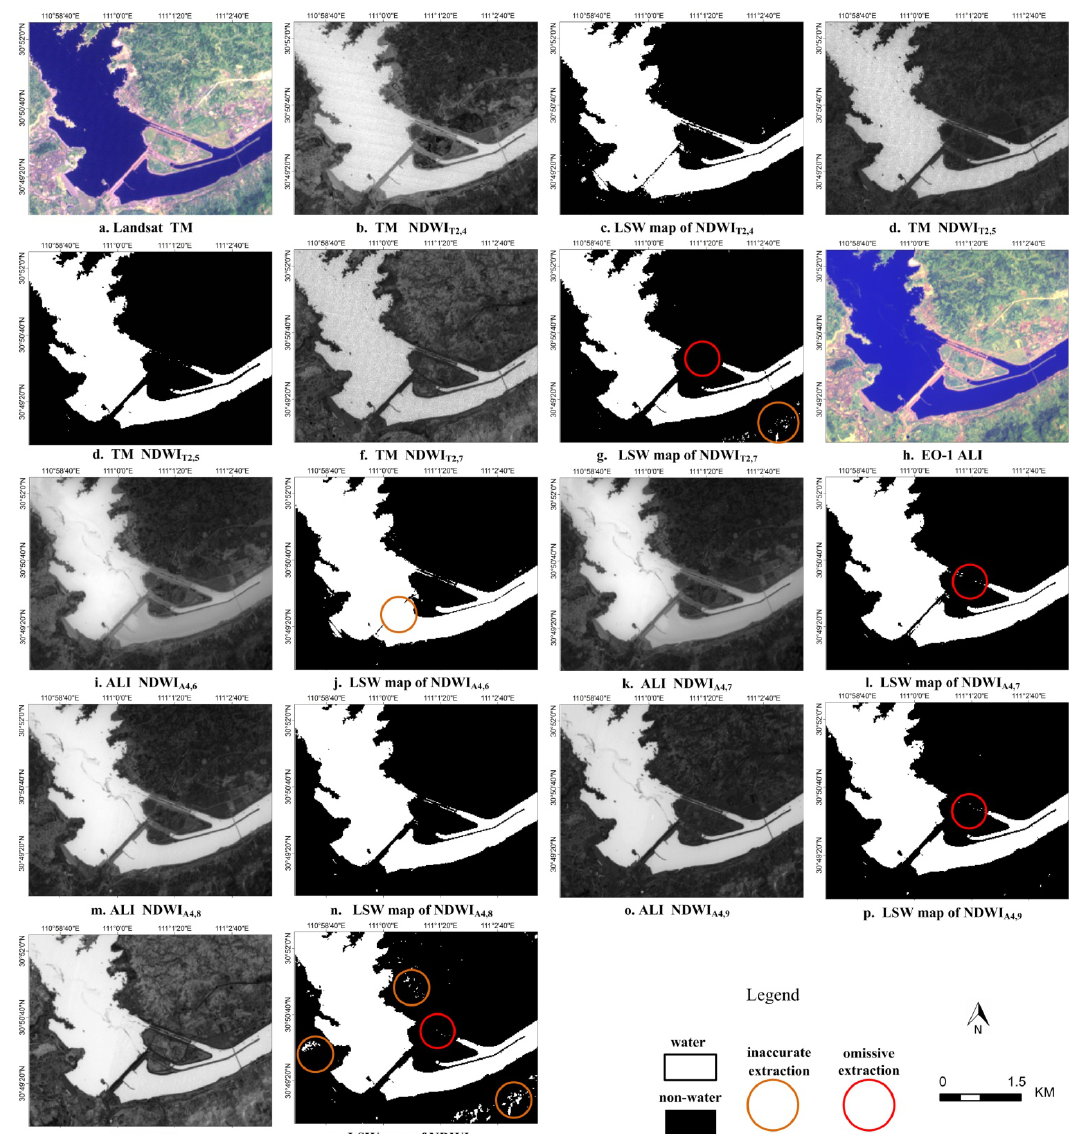
Figure 2. Original images and the resulting LSW maps from Landsat TM imagery and EO-1 ALI imagery in Region I. ( a ) Landsat TM image (2 May 2010) false-color composite ; (RGB: 752); ( b ) NDWI calculated from TM Bands 2 and 4; ( c ) LSW map of NDWI T2,4 ; ( f ) NDWI ( d ) NDWI calculated from TM Bands 2 and 5; ( e ) LSW map of NDWI T2,5 ; ( h ) EO-1 ALI image calculated from TM Bands 2 and 7; ( g ) LSW map of NDWI T2,7 (30 September 2010) false-color composite (RGB: 1094); ( i ) NDWI calculated from ALI ; ( k ) NDWI calculated from ALI Bands 4 and 7; Bands 4 and 6; ( j ) LSW map of NDWI A4,6 ; ( m ) NDWI calculated from ALI Bands 4 and 8; ( n ) LSW map ( l ) LSW map of NDWI A4,7 ; ( o ) NDWI calculated from ALI Bands 4 and 9; ( p ) LSW map of NDWI ; of NDWI A4,8 A4,9 ( q ) NDWI calculated from ALI Bands 4 and 10; ( r ) LSW map of NDWI A4,10